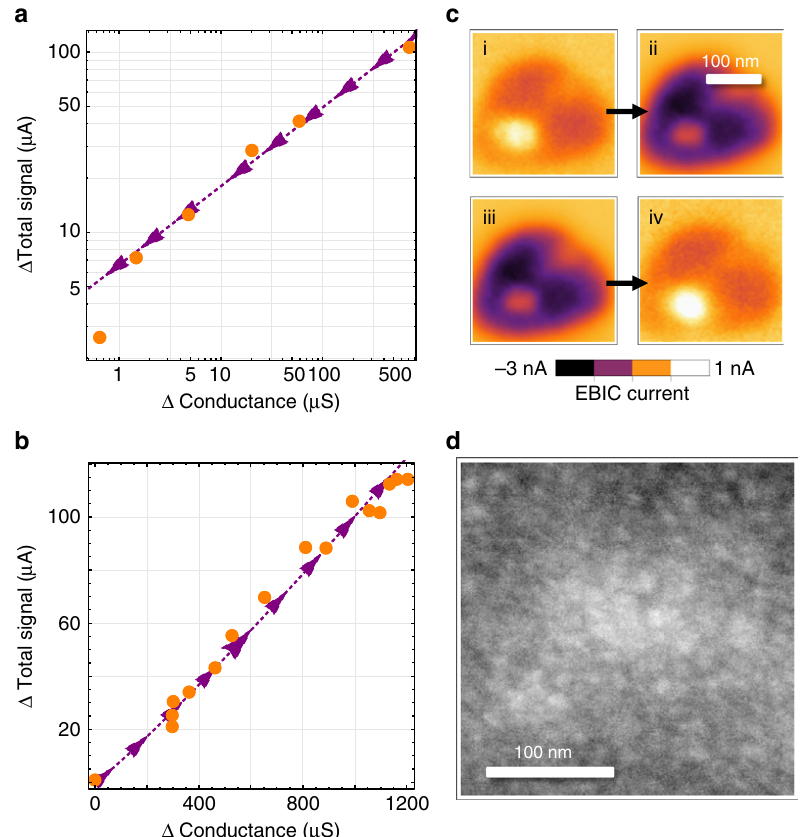
Fig. 8 Conductance signal relationships. a Comparison of the change in conductance measured at 0.1 V from the off state ( Δ Conductance) and the measured change in total signal in an image ( Δ Total signal). Scaling dependence of the total electron beam-induced current (EBIC) signal at 5 keV in turn- off branch with sublinear exponent 0.43 ± 0.15 (95% con fi dence). b Scaling dependence of total EBIC signal in turn-on branch with near linear exponent 1.10 ± 0.10 (95% con fi dence), c EBIC depiction of an on (i) to of (ii) and off (iii) to on (iv) transition. A compilation of switching micrographs for this process is available in Supplementary Movie 1. d Scanning electron microscopy image after switching showing no tearing of the